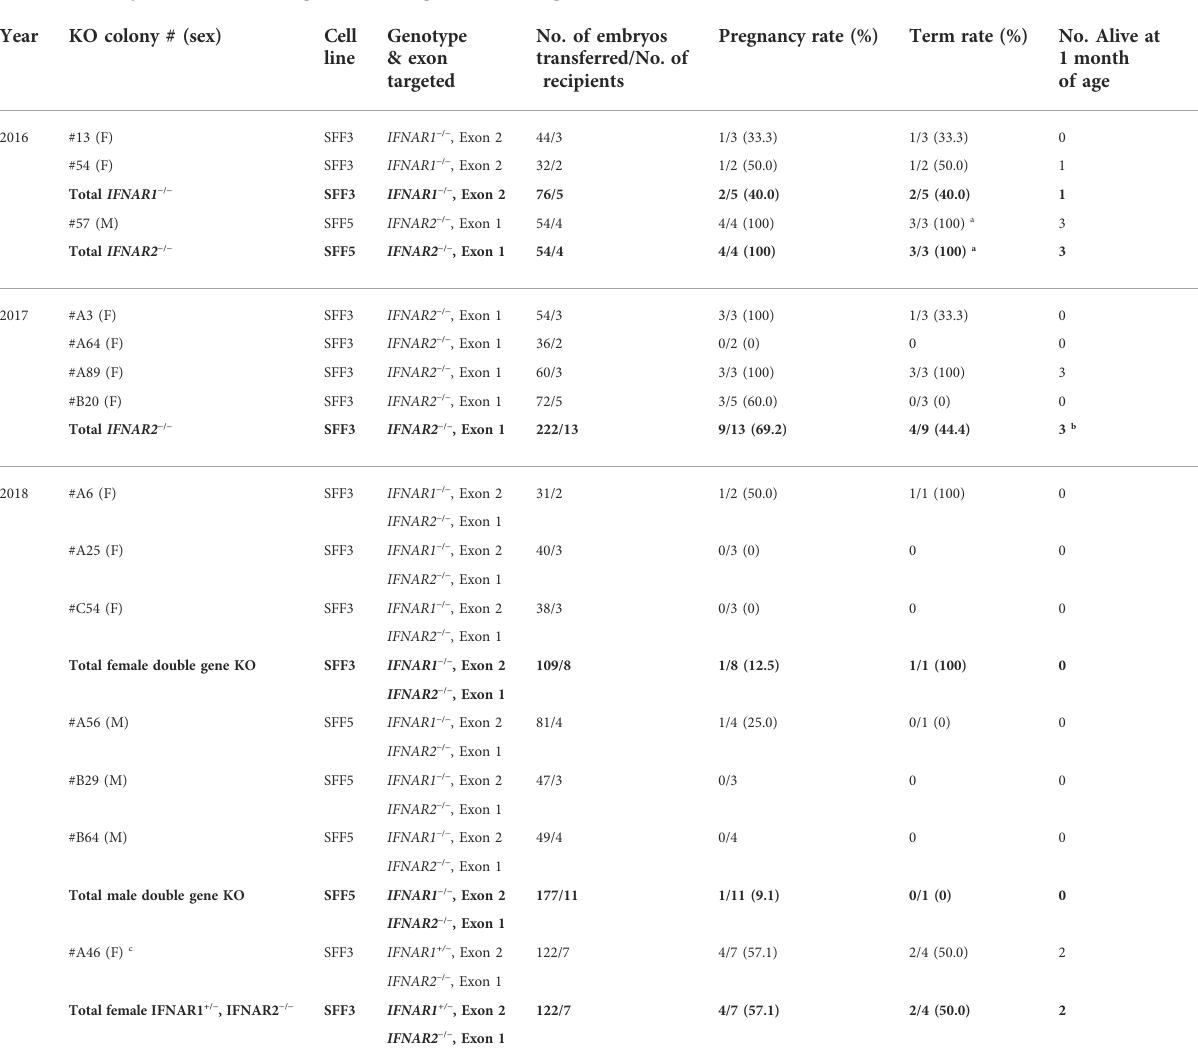
TABLE 4 Development rates following SCNT for single and double gene knockout